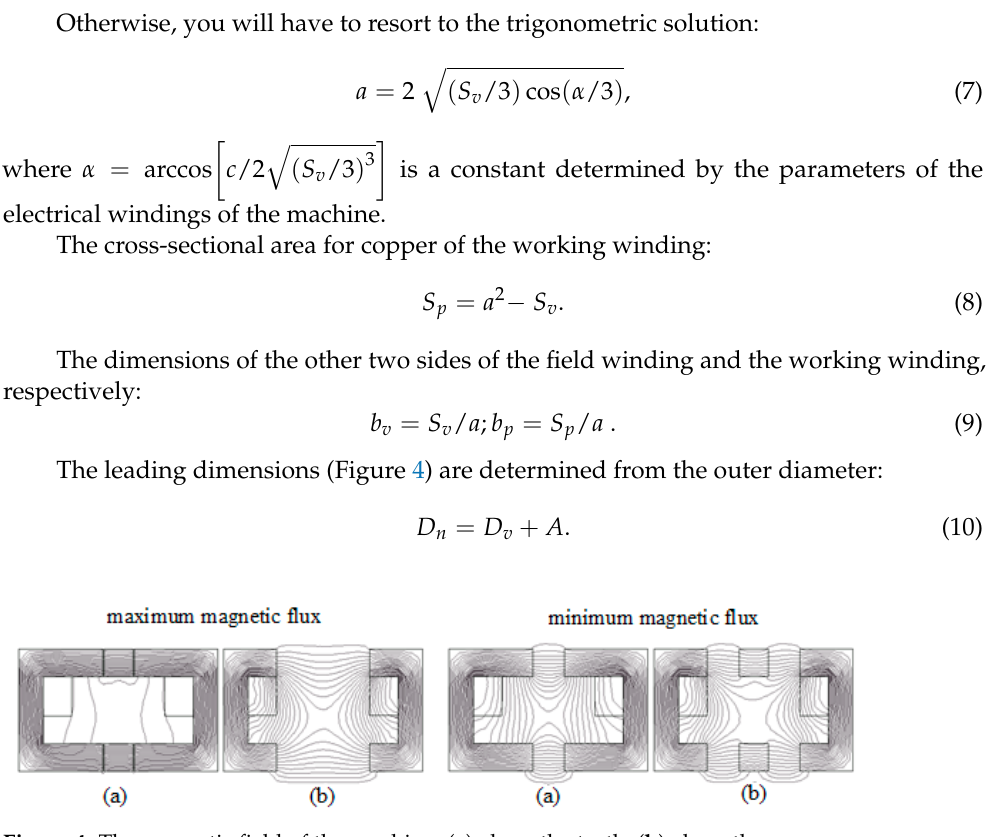
Figure 4. The magnetic field of the machine: ( a ) along the teeth; ( b ) along the grooves. The total size of the core of the module A and its width l z are set from the condition of the optimal ratio of copper and steel.